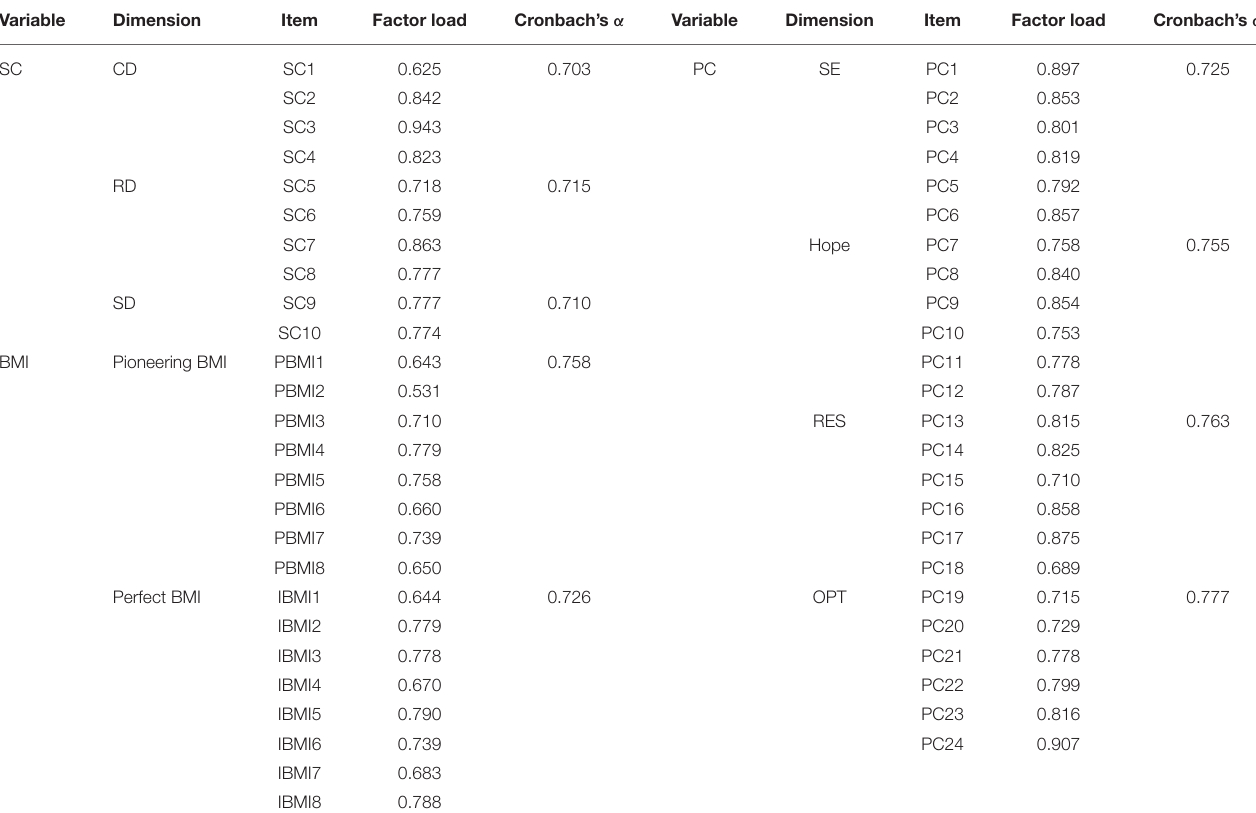
TABLE 4 | Reliability and validity analysis ( n =